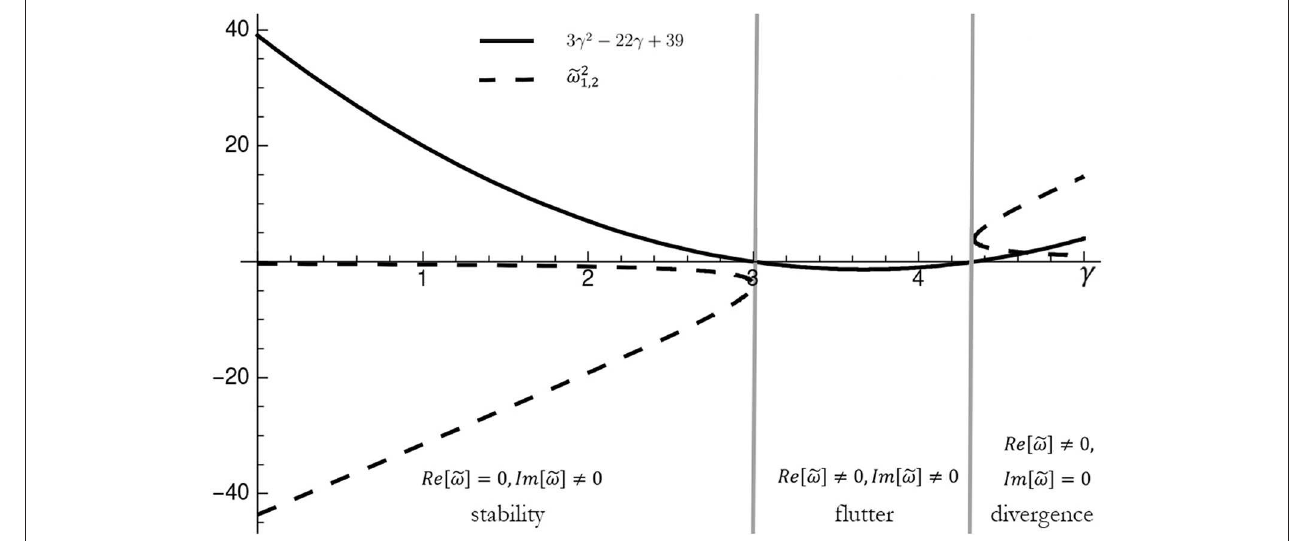
FIGURE 10 | Graphical study of Equation (11) to identify the region of stability, for v